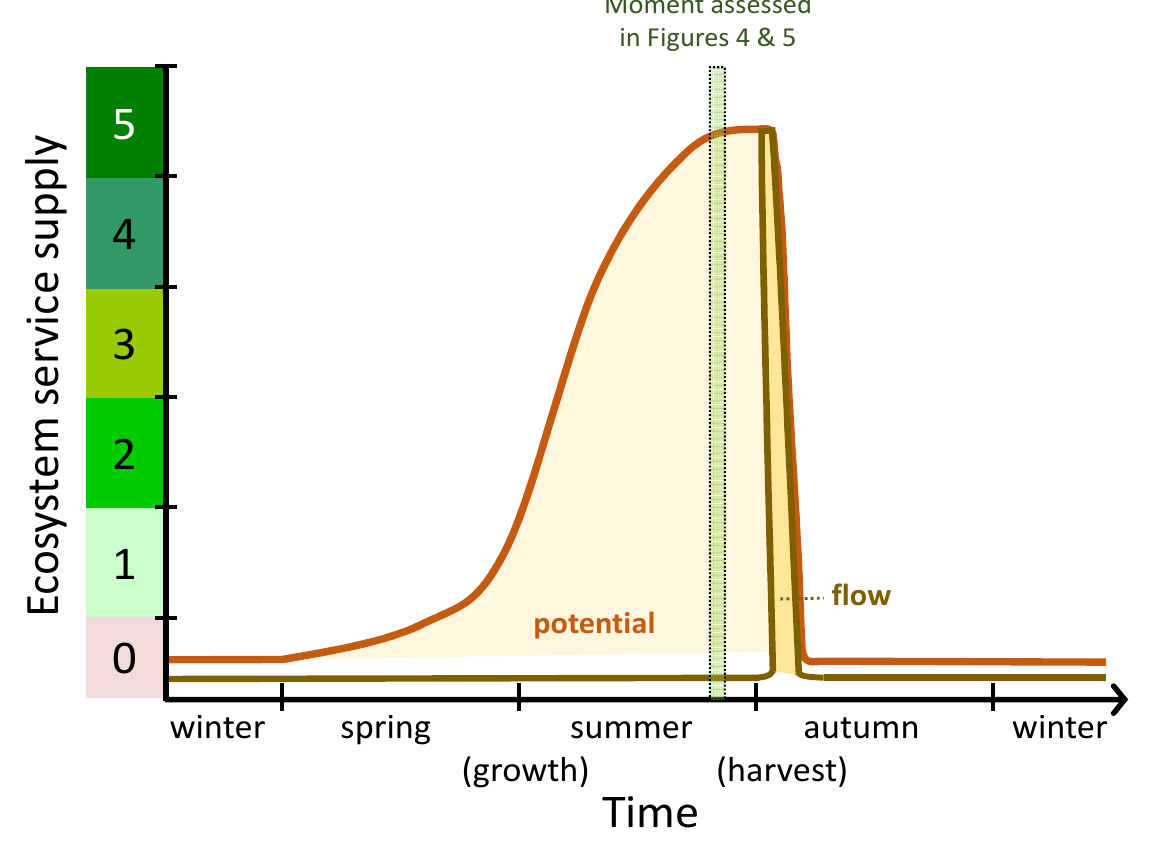
Figure 3: Ecosystem service supply potential and flow. Example monoculture summer annual (e.g. wheat) crop-related food provisioning ecosystem service during growing and harvest period (compare values with Figures 4 and 5).